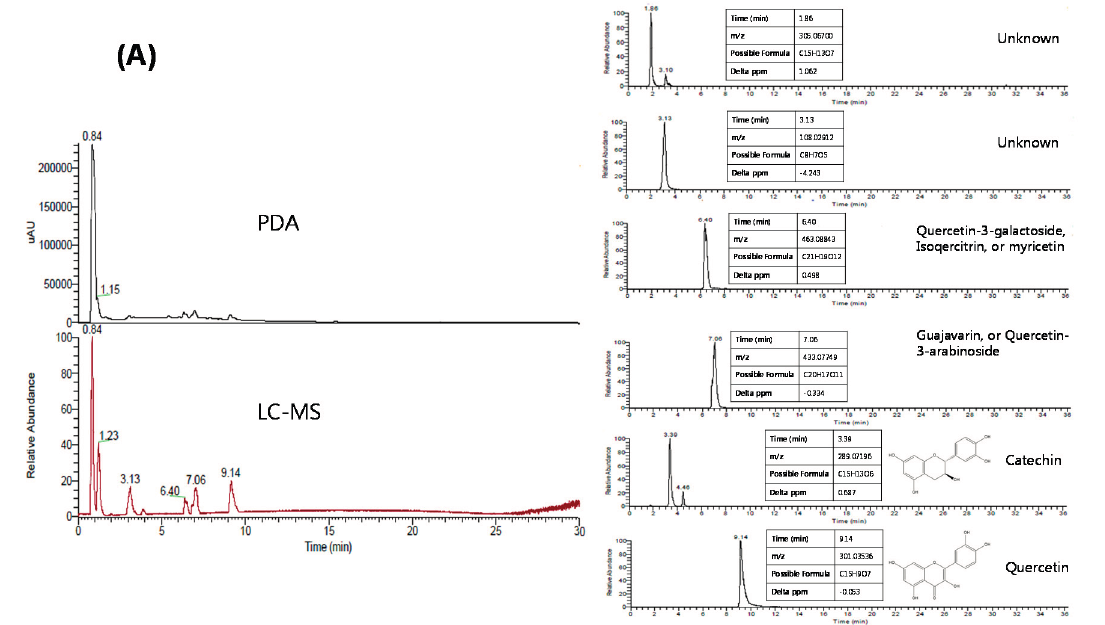
Figure 2. Comparison of the inhibitory effects of nine culinary plant extracts on fructose transport in Caco-2 cells. Cells were incubated in Krebs buffer containing 10 mM of [ 14 C] fructose and 500 μ g/mL concentrations of each sample for 10 min at 37 °C. Transport was determined by scintillation spectrometry. Values represent the mean ± SE. *** p < 0.0001 vs. the vehicle-treated